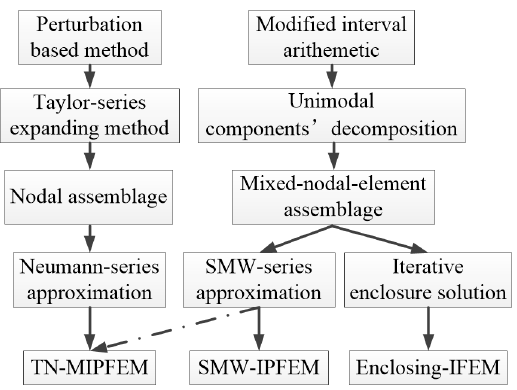
Figure 4. Relationship between three different